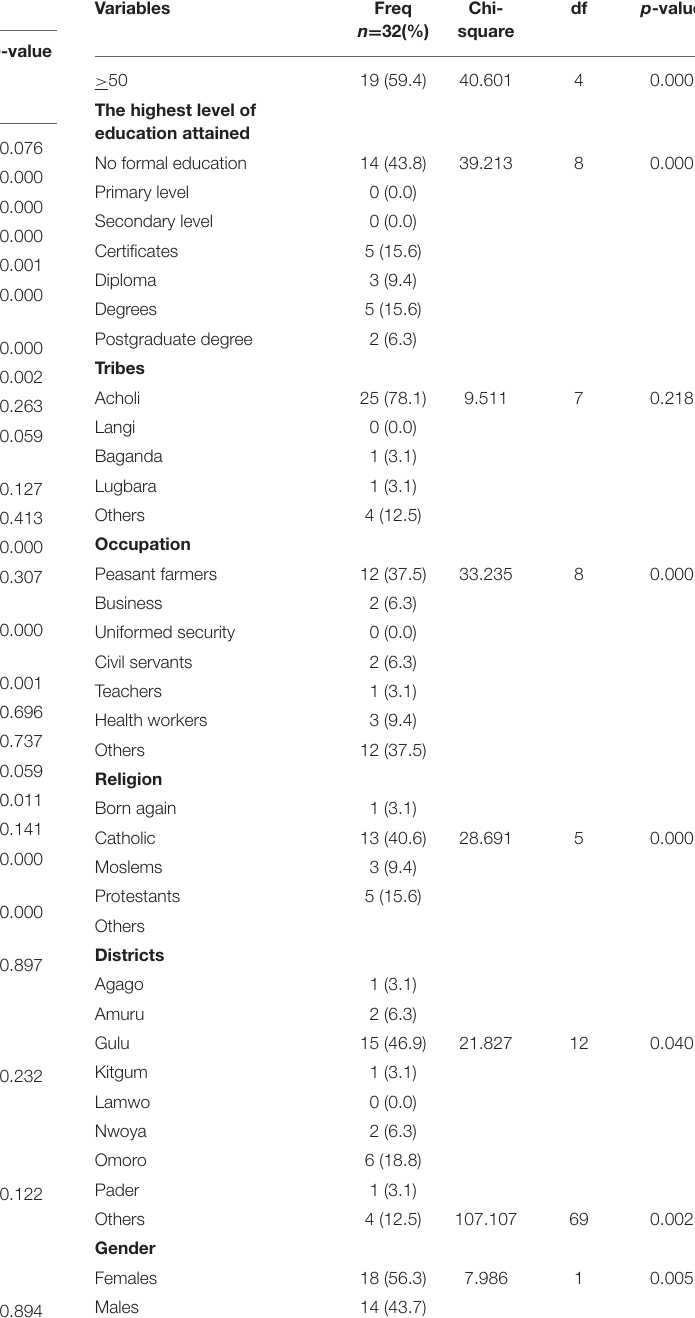
TABLE 2 | Factors associated with mortality at the bivariate analysis on the COVID-19 patients treated at Gulu Regional Referral Hospital from March 2020 to October 2021.